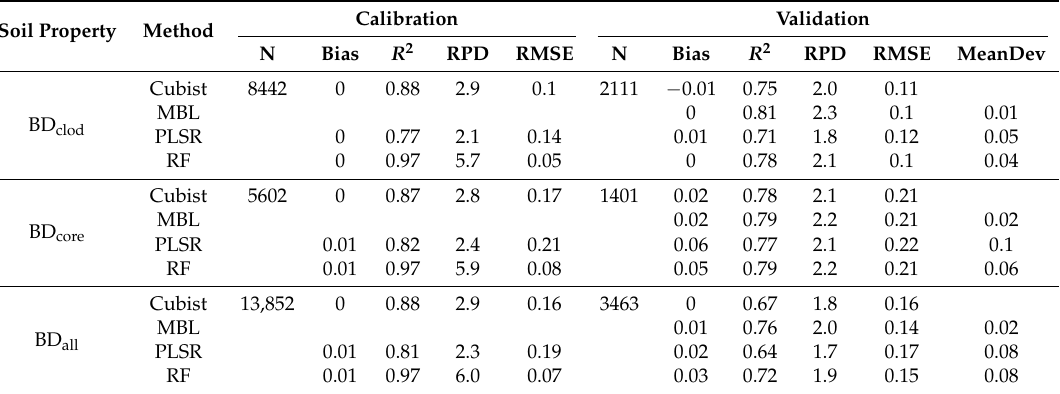
Figure 3. Comparison of the MBL model predictions from an independent validation set with observations obtained using combined clod and core ( a ), clod-only ( b ) and core-only ( c ) methods for measuring bulk density (BD). Table 4. Calibration and validation results of soil bulk density using PLSR and machine learning (memory-based learner (MBL), Cubist and random forest (RF)) models. Prediction of soil bulk density was assessed by fitting the model using data from two analytical methods (clod—volume measured at 1/3 bar water tension and core—volume measured at field soil moisture condition) and the two analytical methods combined (BD all ). All predictions were back-transformed prior to calculating goodness-of-fit